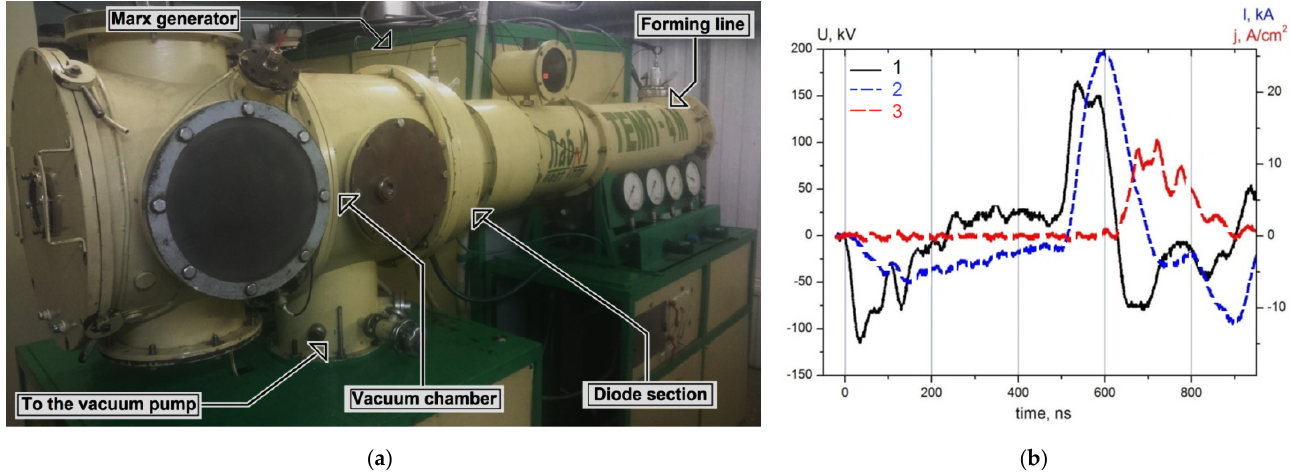
Figure 1. The ‘Temp-4M’ HIPIB accelerator ( a ) and typical waveforms ( b ): 1—accelerating voltage; 2—diode current; 3—current density on a target.